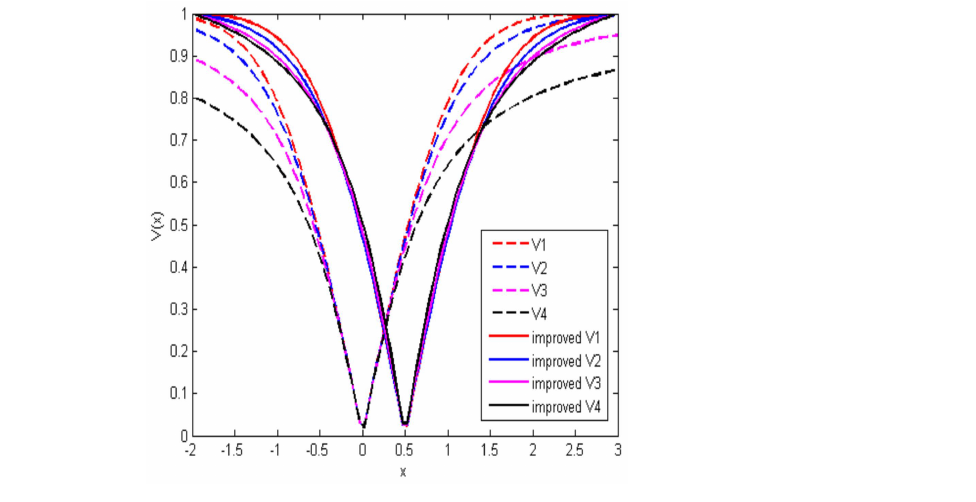
Figure 2. The original (the four dotted lines) and improved (the four solid lines) V-shaped families of transfer functions.